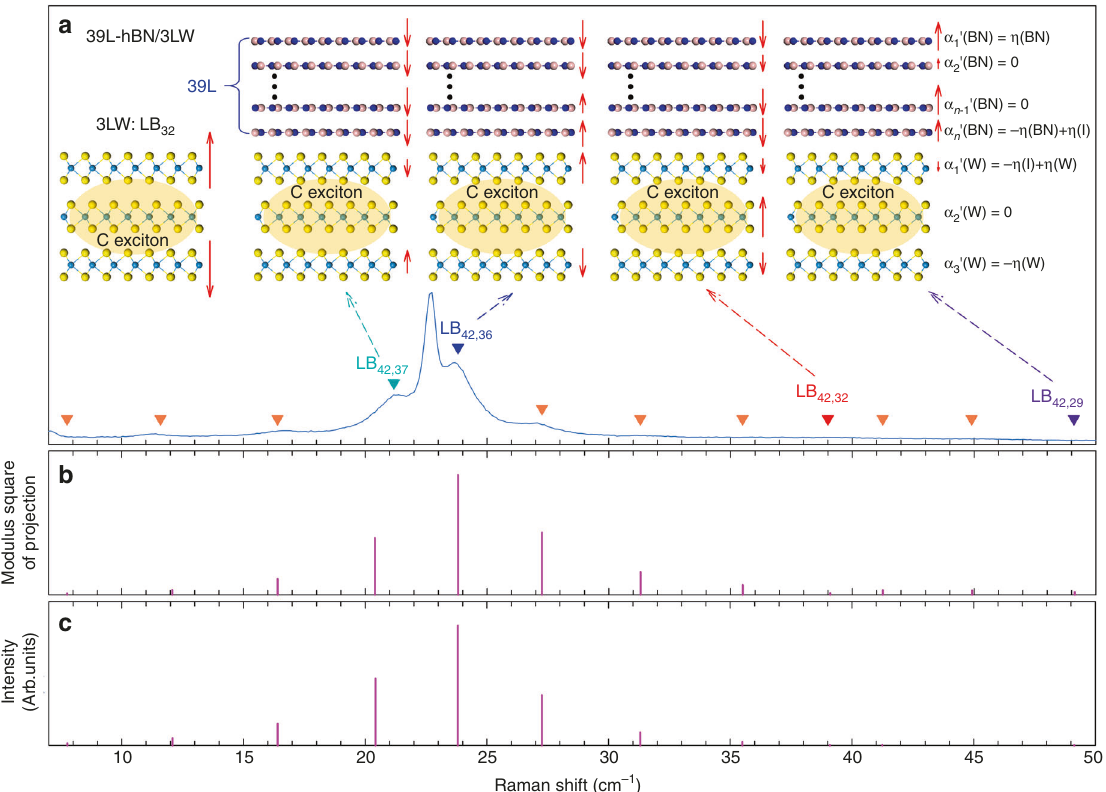
Fig. 4 Schematic diagram for constituent-vdWH EPC of the LB modes in hBN/WS 2 vdWHs. a Raman spectrum of a 39L-hBN/3LW in the region of 5~50 cm − 1 and the normal mode displacements (red arrows) of the LB 42,37 , LB 42,36 , LB 42,32 , and LB 42,29 modes in a 39L-hBN/3LW and the LB 3,2 in a standalone 3LW fl ake. The triangles represent the representative expected LB modes in the 39L-hBN/3LW based on the LCM. In the n L-hBN/3LW ( n = 39), α ′ i (BN) ( i = 1, 2, … , n ) and α ′ j (W) ( j = 1, 2, 3) are the polarizability derivative of the entire layer i from hBN constituents and layer j from WS 2 constituents with respective to the displacement in the z direction. b The modulus square of the projection from wavefunction of different LB modes in 39L-hBN/3LW vdWH onto the wavefunction of the LB 3,2 mode in a standalone 3LW fl ake. c The relative intensity of LB modes in 39L-hBN/3LW